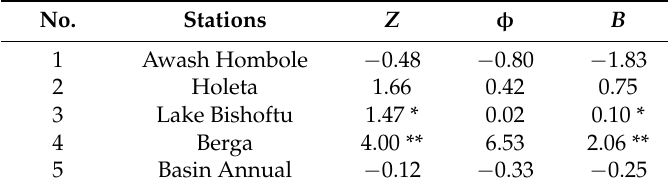
Table 6. Results of MK, ITAM, and Sen’s slope estimator tests for annual discharge.